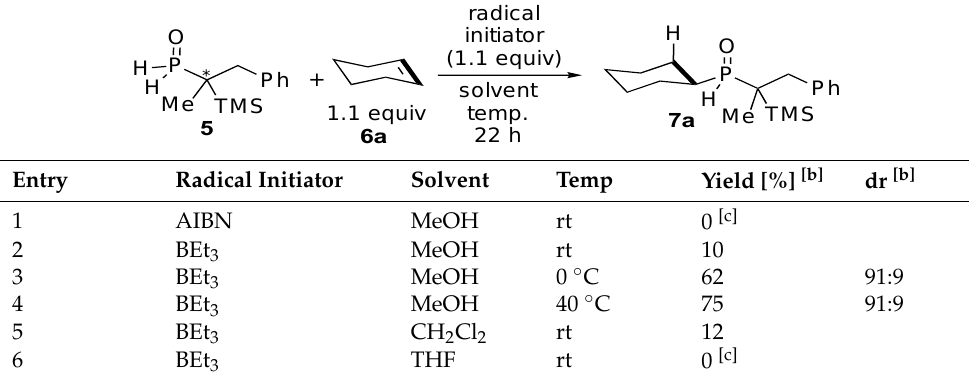
ray molecular structure analysis [50] (Figure 1). The results showed that the phosphorus and carbon atoms adopted S configurations. Table 1. Optimization of radical addition [a] . Table 1. Optimization of radical addition [a].